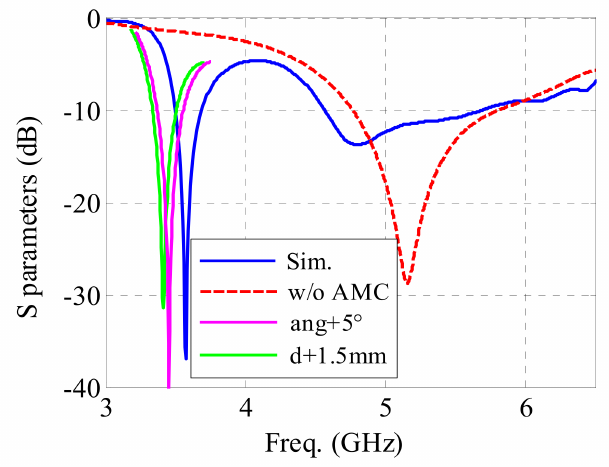
Figure 10. S parameter of the proposed antenna sensor. The red line indicates the result of the antenna without the AMC structure.